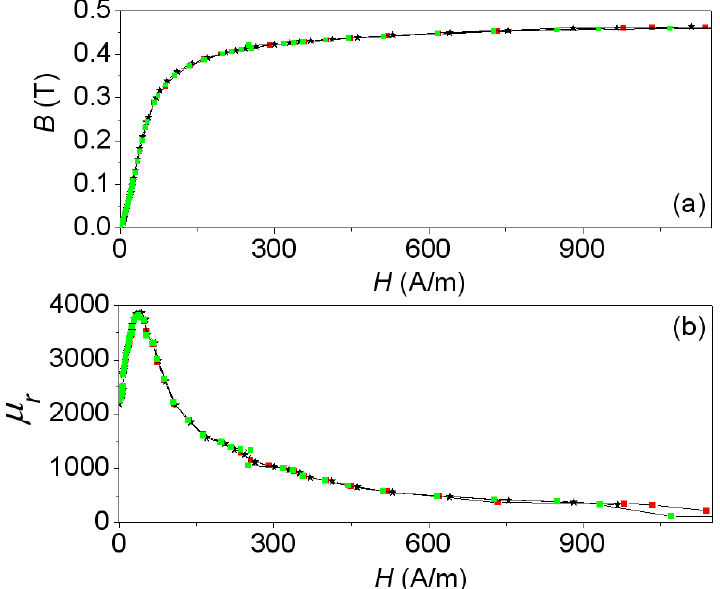
Figure 9. ( a ) B-H curves; and ( b ) μ (    ) and 3D simulations (   